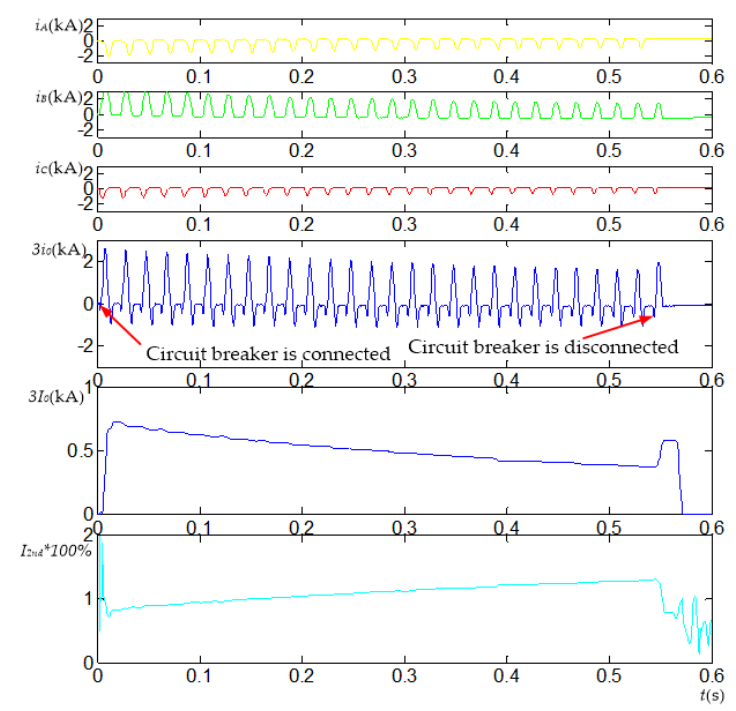
Figure A4. Recorded waveform No. 3 (0 s–0.6 s).